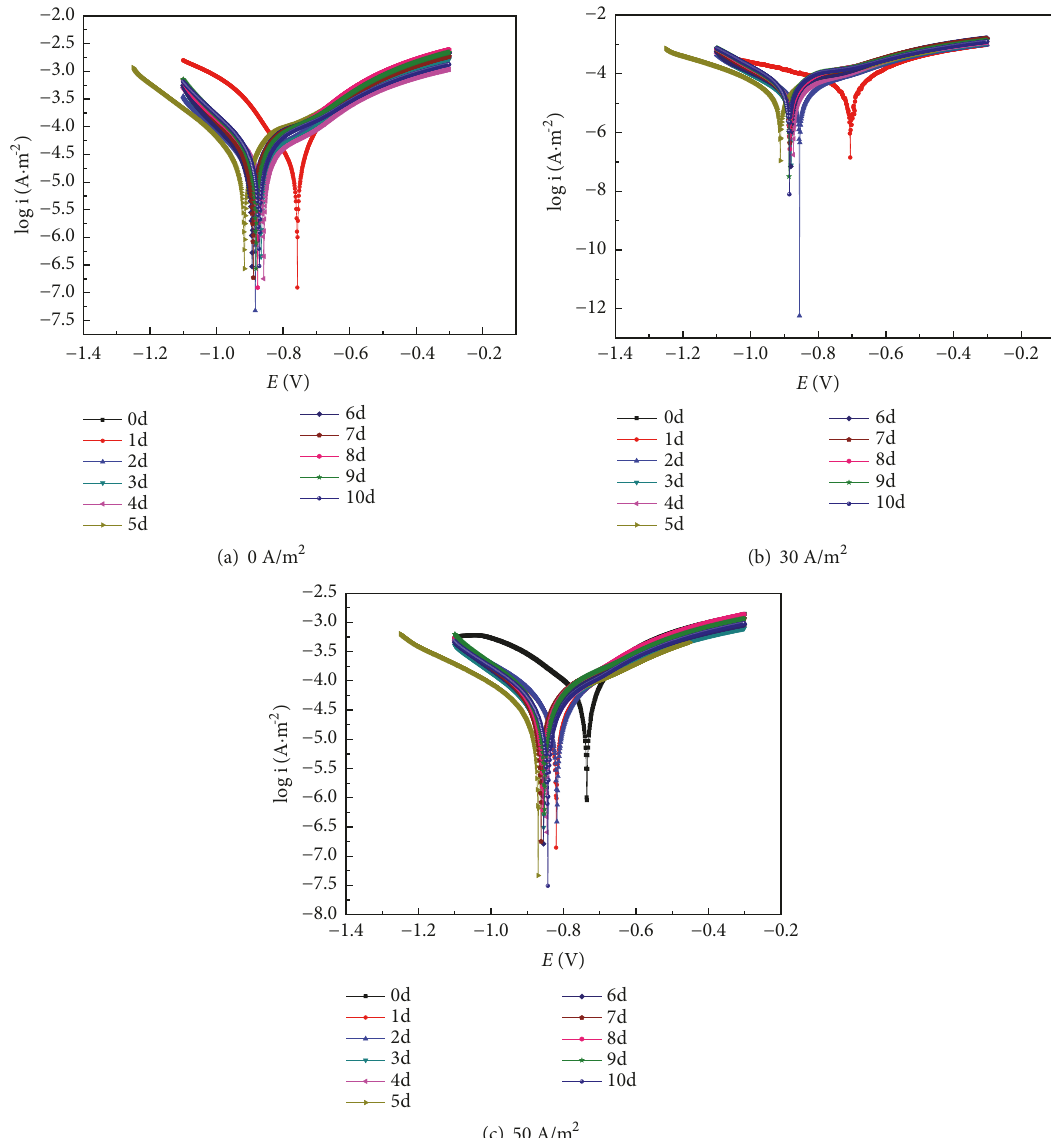
Figure 4: Polarization curve under different AC current